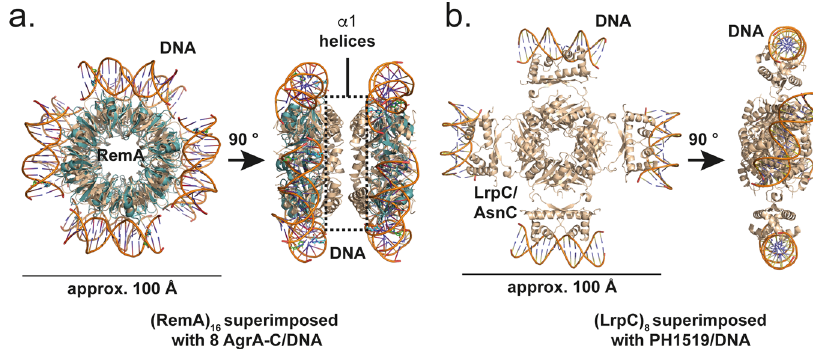
Fig. 4 Structural comparison of the DNA-binding protein oligomers RemA and LrpC. a Superimposition of eight DNA-bound AgrA-Cs (cyan; PDB-ID: “ 3BS1 ” ) onto (RemA) “ 7BM2 ” ). b Structure of the transcriptional regulator LrpC from B. subtilis (PDB-ID: “ 2CFX ” ) superimposed with 16 (orange; PDB-ID: PH1519 domain bound to DNA (PDB-ID: “ 2E1C